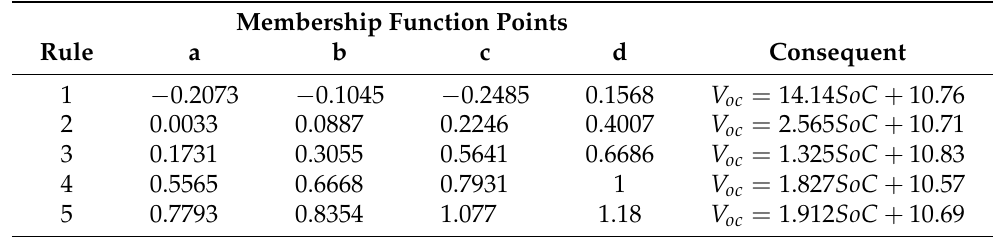
Table 3. Parameters of the membership functions and consequents of the rules used for the model that determines the V oc for a given SoC . The points correspond to trapezoidal membership functions, as shown in Figure